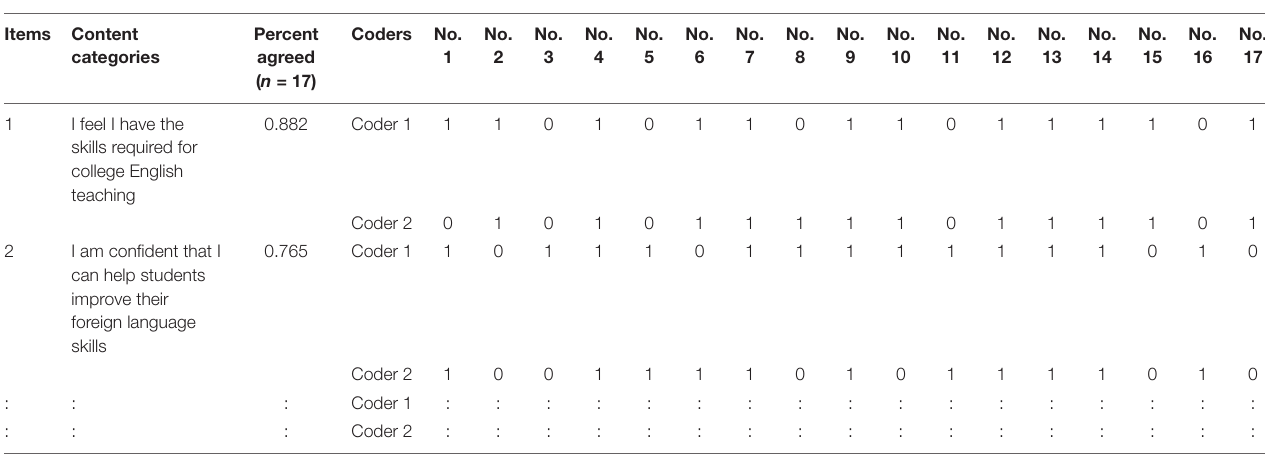
FIGURE 1 | The scale development procedures in our study. TABLE 1 | Example of percentage agreed